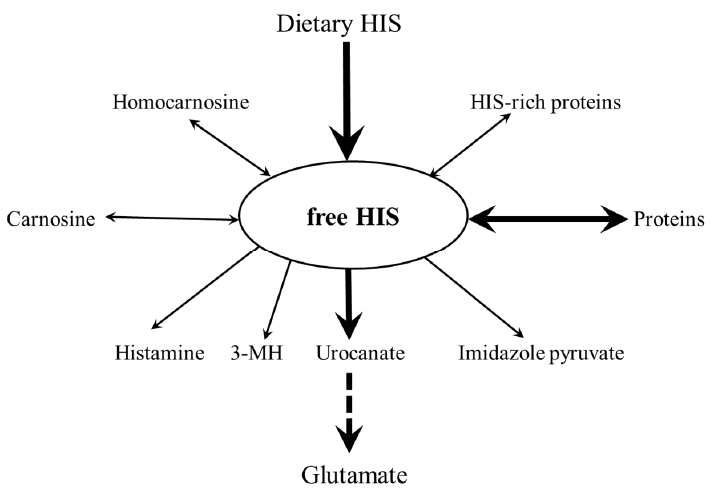
Figure 2. Main pathways of HIS metabolism. Most HIS metabolism is directed to protein turnover and catabolism to glutamate. The minor pathways, such as synthesis of carnosine (CAR), histamine, and HIS-rich proteins, make HIS unique among other amino acids.